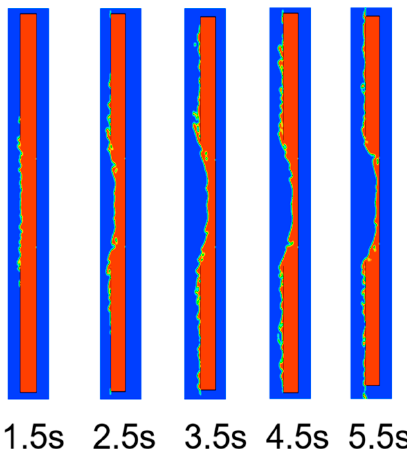
Figure 15. Process of heat flow penetrating the steel target.